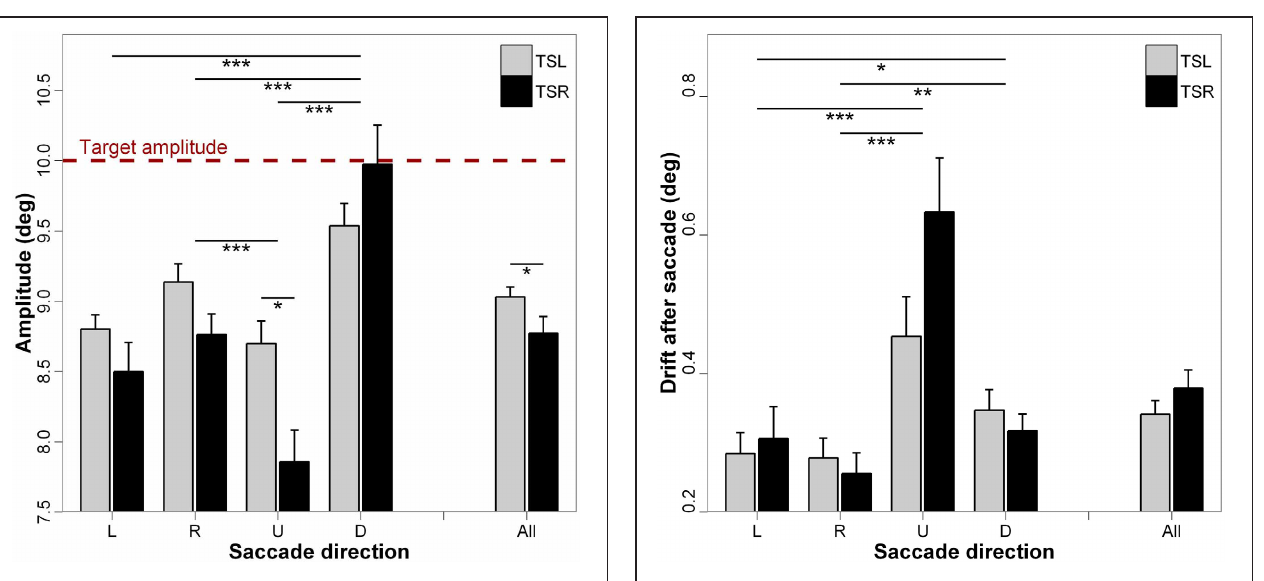
FIGURE 6 | Absolute mean values of fixation drift after saccades for each saccade direction (L, leftward; R, rightward; U, upward; D, downward) and tinnitus side (TSL, tinnitus side left; TSR, tinnitus side right). Error bars represent the standard error. The symbol * indicates a statistically significant effect ( ∗ p < 0 . 05; ∗∗ p < 0 . 01; ∗∗∗ p < 0 .